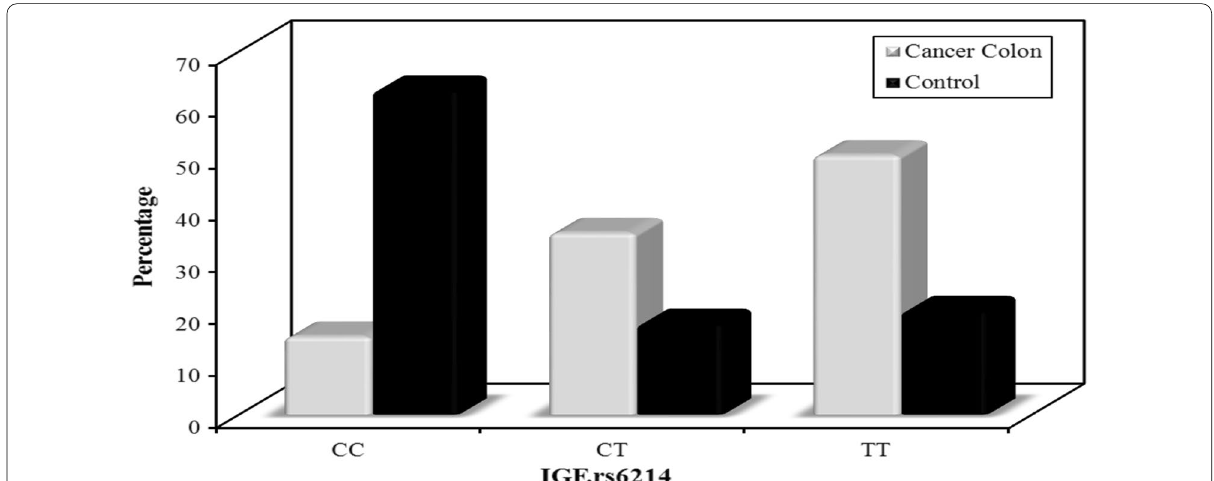
Fig. 1 Comparison between the two studied groups (colorectal cancer group (n.80) and control group (n. 80)) regarding to IGF-1 rs6214(C/T)